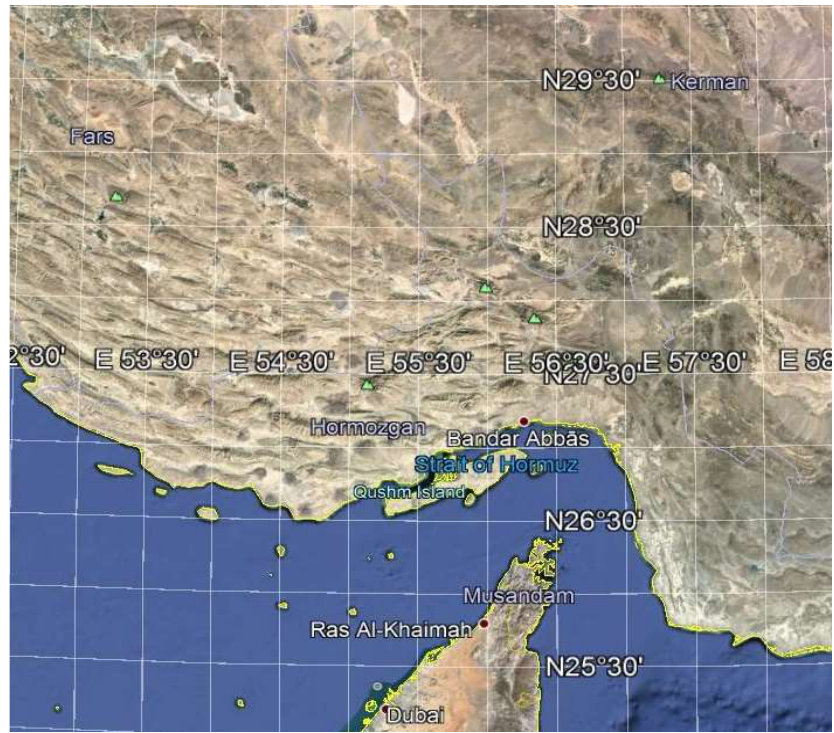
Figure 1. The area of interest; the coastal area of the southern part of Iran, dashed lines show the target area.